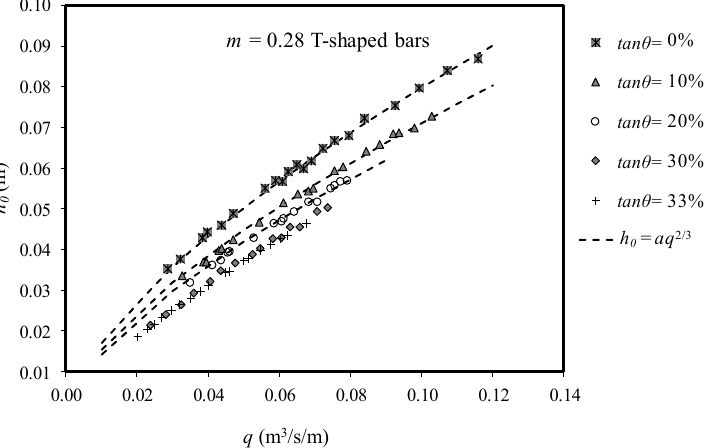
Figure 10. Flow depth at the beginning of the rack h 0 as a function of the incoming flow q . T-shape bars with void ratio m = 0.22.